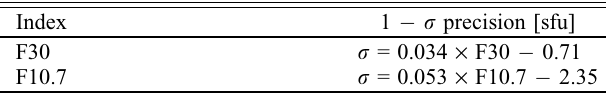
Table 1. Precision of the radio indices. Values are expressed in solar flux units